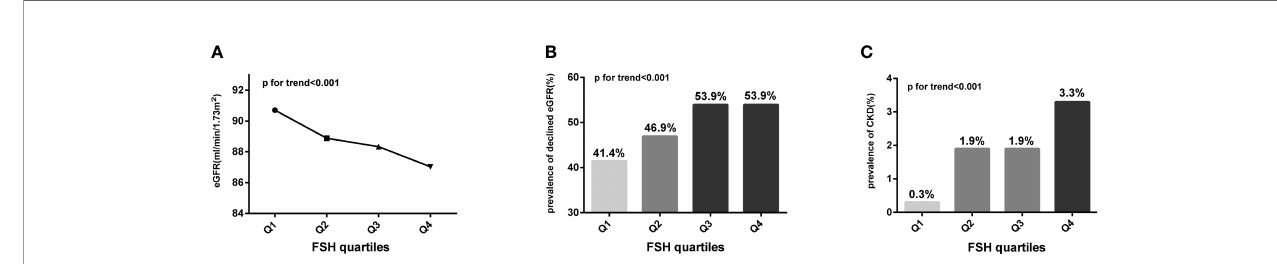
FIGURE 2 | Trends for various indicators of renal function with increasing FSH quartiles (expressed as Q1, Q2, Q3, and Q4) in post-menopausal women. (A) Trend for eGFR; (B) trend for the prevalence of declined eGFR; (C) trend for the prevalence of CKD. Analysis of variance (ANOVA) trend test and Cochran – Armitage chi- squared tests for trend were conducted to assess the trends of continuous and categorical variables, respectively. FSH, follicle-stimulating hormone; eGFR, estimated glomerular fi ltration rate; declined eGFR, eGFR<90 mL/min/1.73m 2 ; CKD, chronic kidney disease.